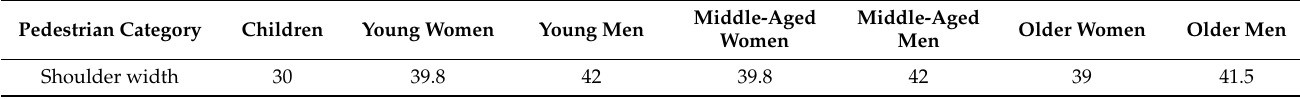
Table 8. Shoulder width of all kinds of people (unit: